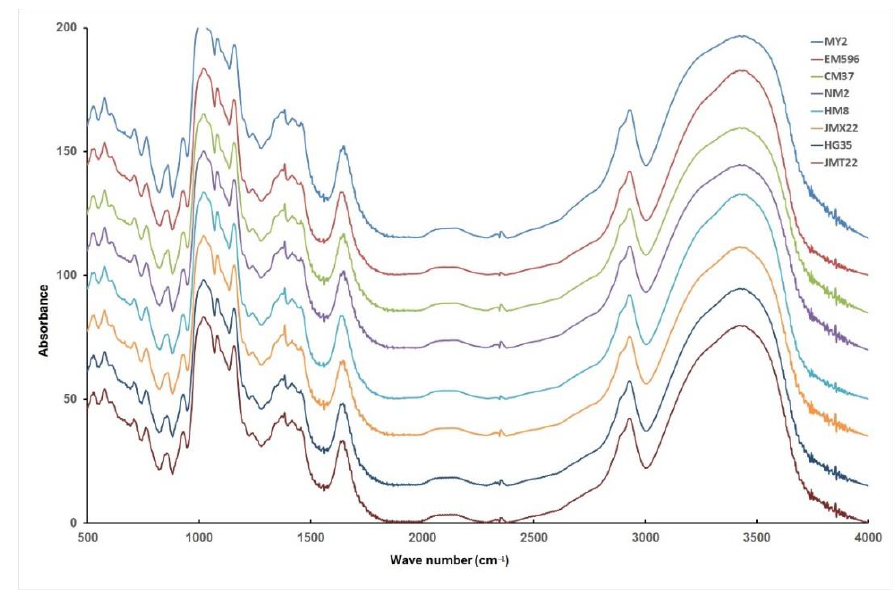
Figure 3. FTIR spectra of starch from wheat varying in grain hardness.